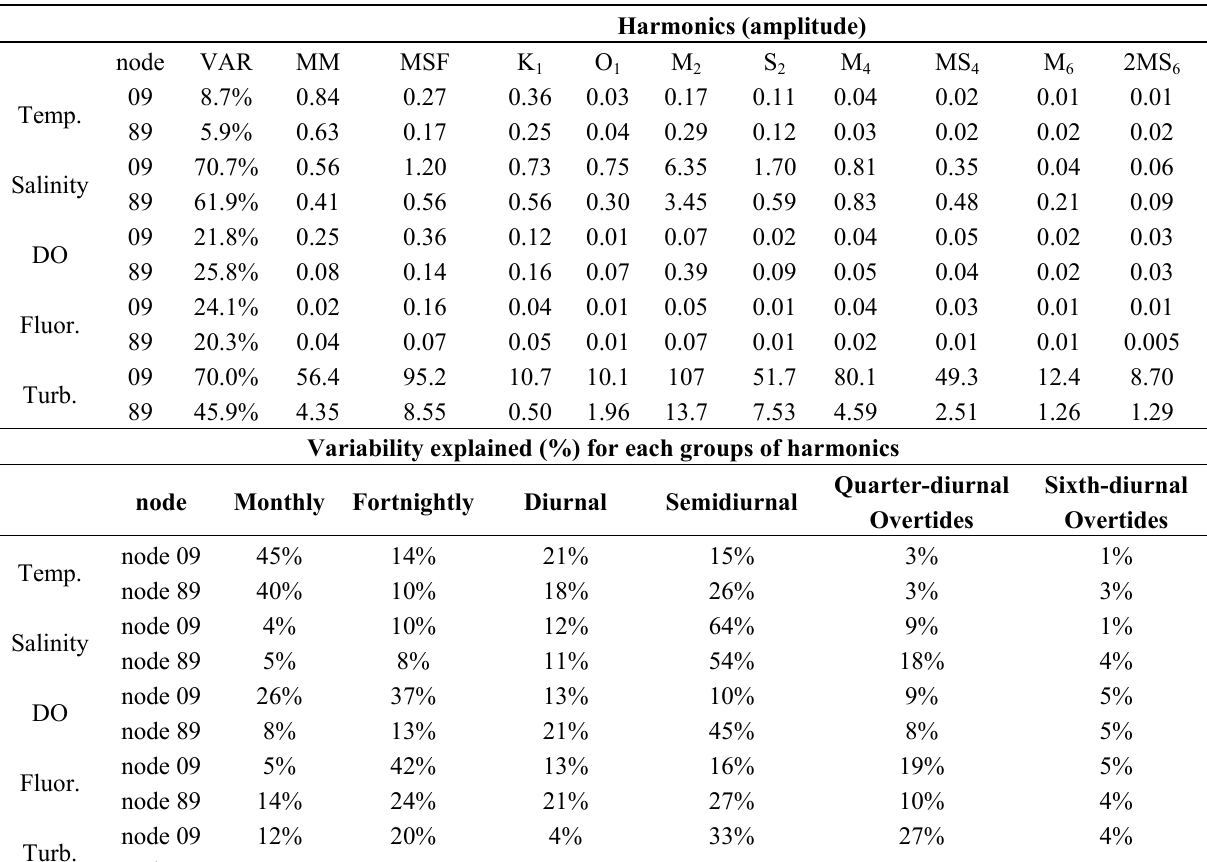
Table 4. Results of the harmonic analysis. VAR stands for the variance explained by the harmonic analysis. The amplitude for the different harmonics for each parameter is also indicated.